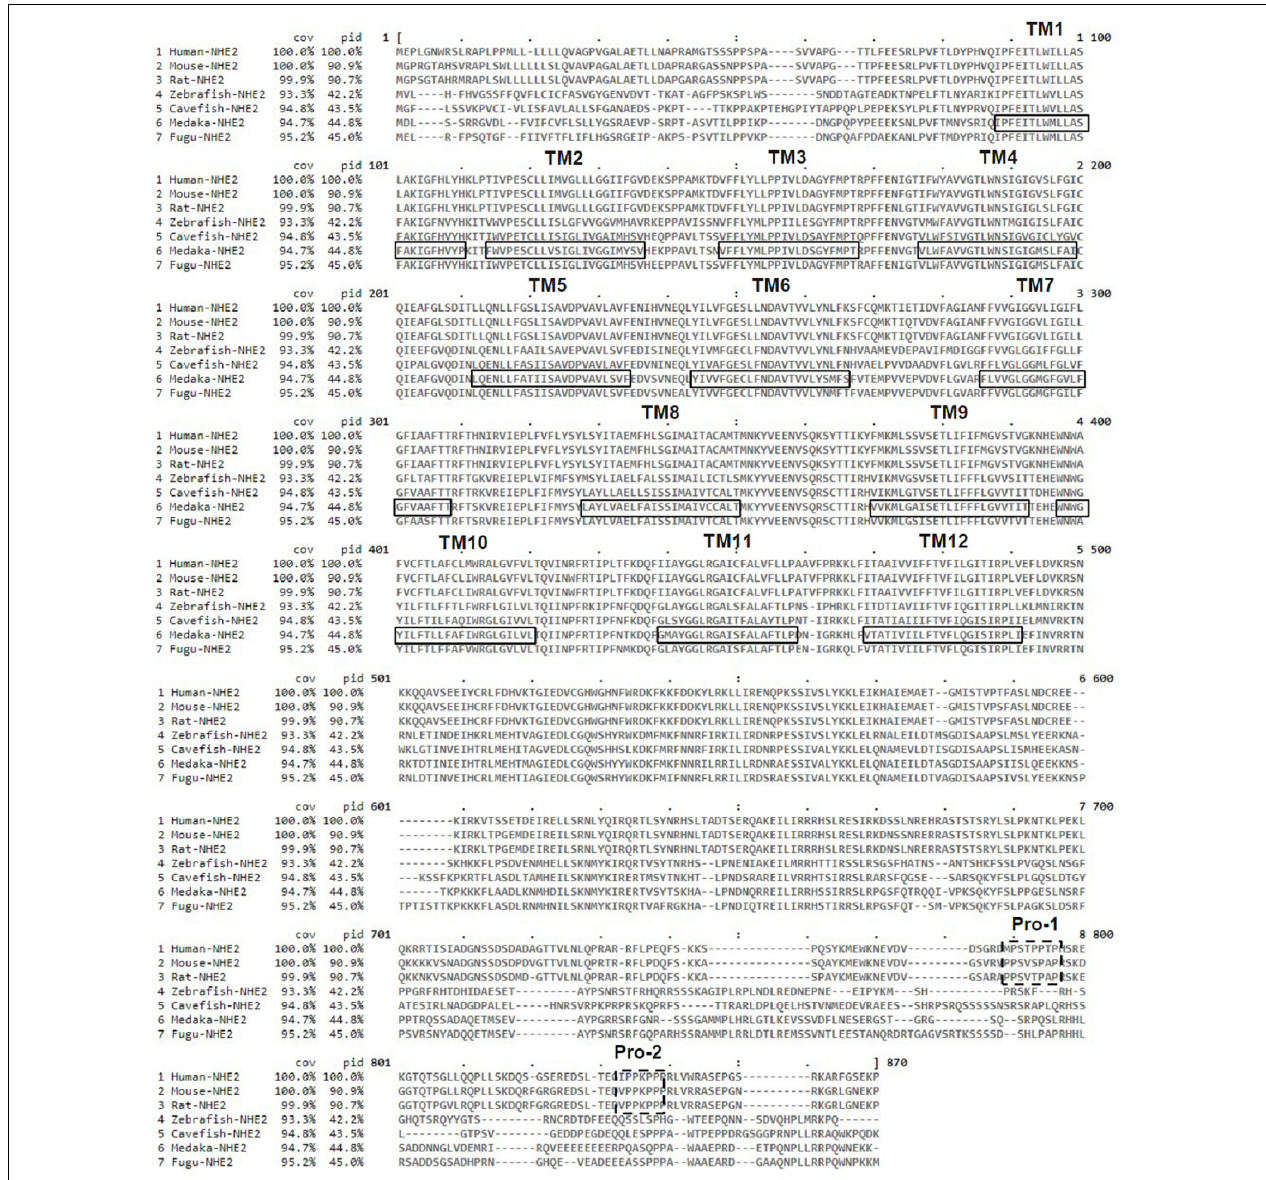
FIGURE 3 | Alignment of the deduced amino acid sequences of Na + /H + exchanger 2 (NHE2) of medaka and other species. The solid line and dotted lines, respectively, mark the postulated transmembrane (TM) domains of NHE2 and proline-rich sequences (Pro-1 and Pro-2).